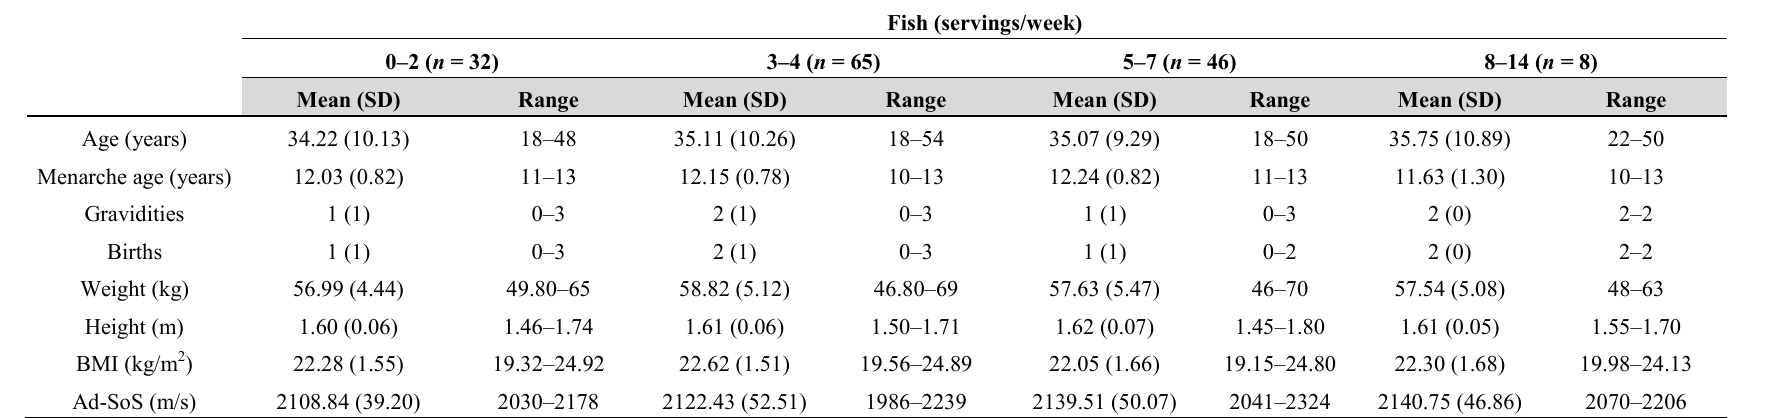
Table 2. Biological and anthropometric factors, distributed by fish consumption in premenopausal Spanish women.